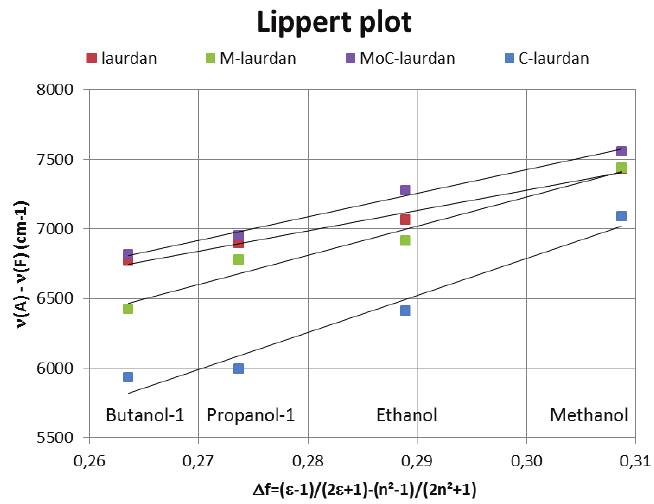
Supplemental Figure S2. We built the Lippert plots of laurdan, M-laurdan, MoC-laurdan and C-laurdan in alcohols (butanol-1, propanol-1, ethanol and methanol). The Lipper plots shows the Stokes shift ( ν gives an estimation of the fluorophores solvent sensitivity. The linearity of the laurdan family curves can be interpreted as a general solvent effect in the spectral shift. Besides, the similarity in the slopes obtained for the different curves drives us to conclude that the different dyes are similarly sensitive to solvent